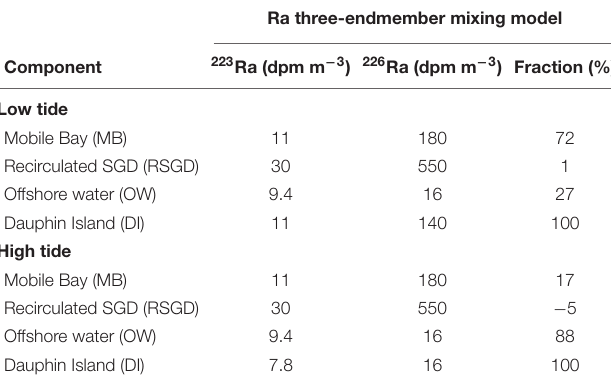
TABLE 2 | 222 Rn-based SGD and nutrient flux estimations. Continuous 222 Rn measurement